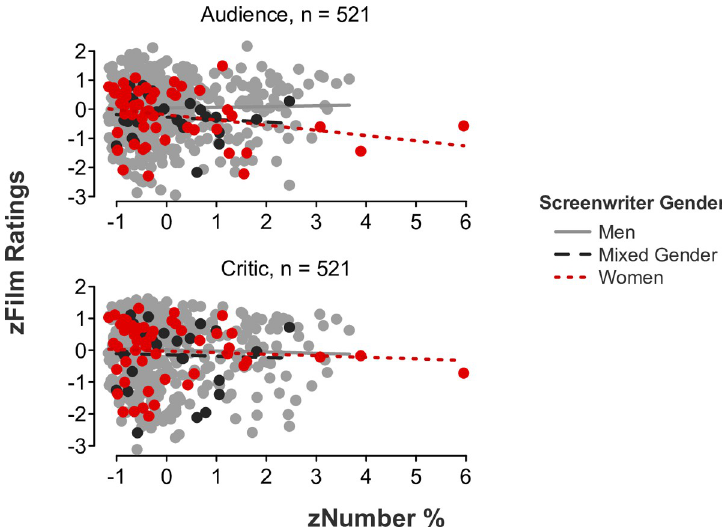
Fig 5. Film ratings as a function of use of numbers, screenwriter gender, and rater role.